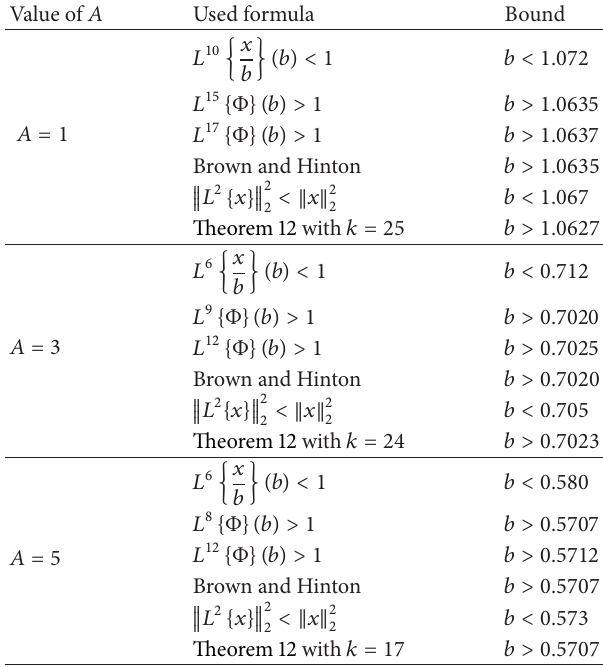
Table 1: Comparison of bounds for 𝑏 in Example